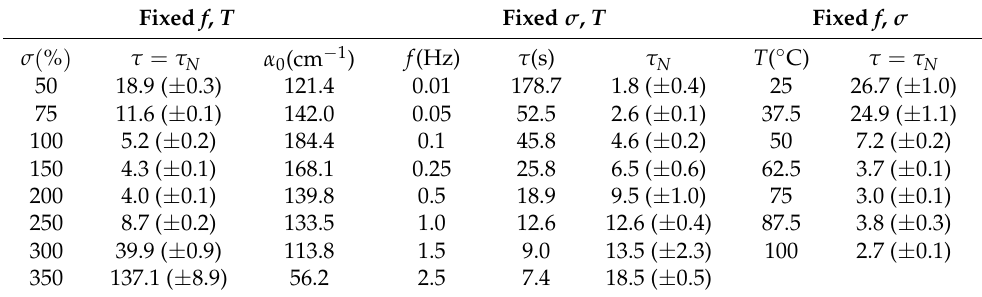
Table 2. Extracted shear-ordering timescales (and thus τ N ) as strain amplitude ( σ ), oscillation frequency ( f ) and temperature ( T ) are varied against the fixed values of σ = 100%, f = 1 Hz, and T = 50 ◦ C. For the strain dependence data, the extracted extinction coefficients ( α 0 ) at λ = 610 nm are also given.